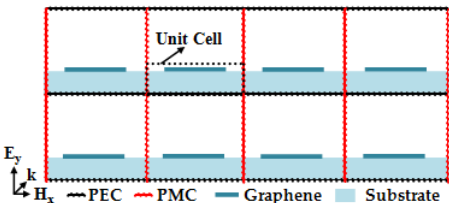
Figure 20. 3D FSS structure with one cell of graphene micro-ribbons and cross-section of the whole structure (in xy